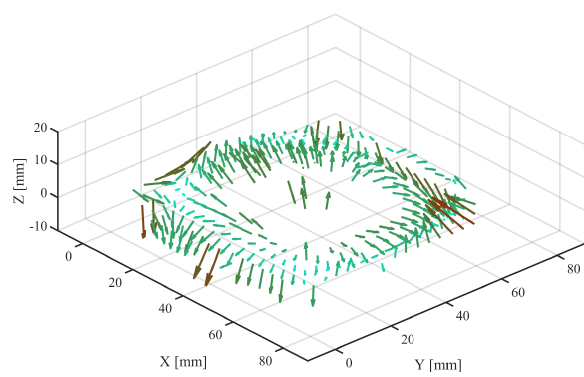
data sets. in Figure 4 for δ X = δ Y = δ Z = 5 mm ) after transformation show a systematic wave-like radial pattern with outside vectors pointing in and inside vectors pointing out. Hence theoretically, errors arise from neglecting refraction in the camera model,